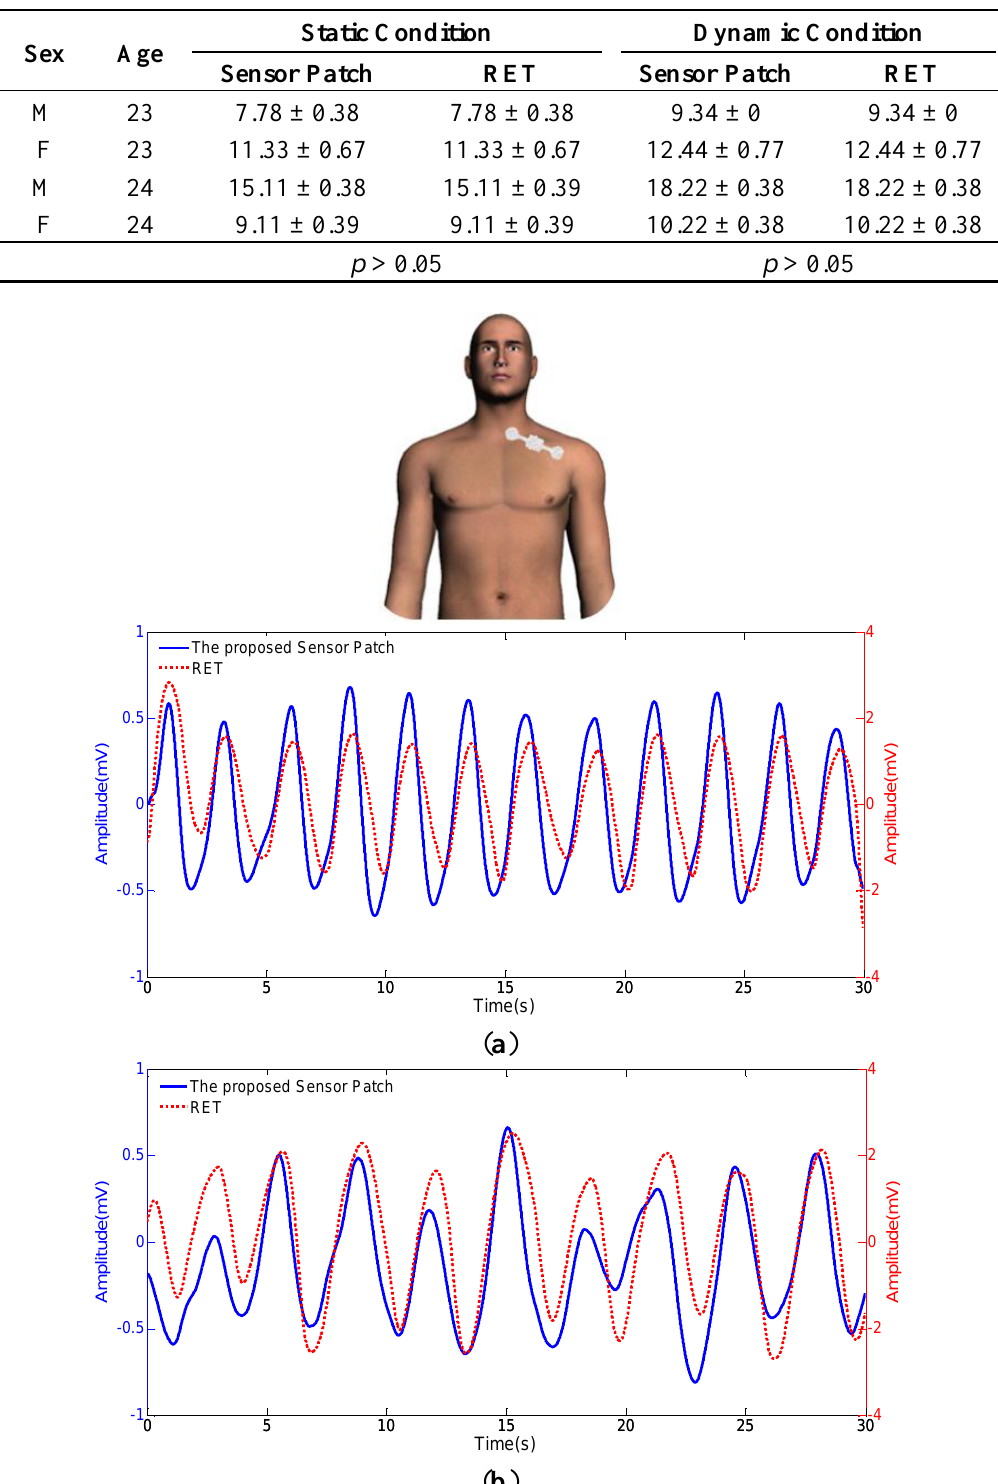
Table 1. Comparison of the respiration rates measured by the proposed sensor patch, and commercial respiratory effort transducer (RET) under static (sitting) and dynamic (walking) conditions; unit: times·min −1 .